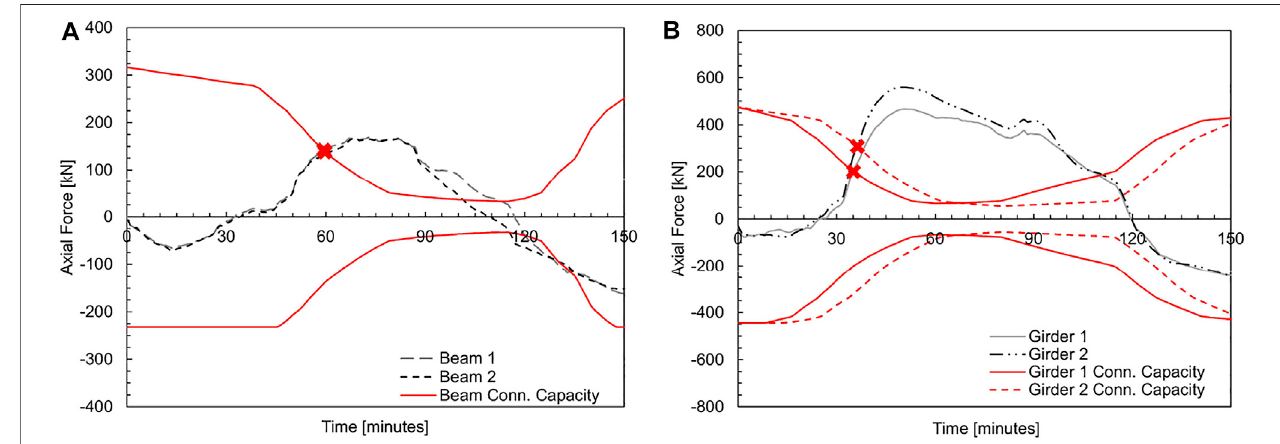
FIGURE 19 | Axial force histories and connection capacities for (A) beams and (B) girders connecting to column C-2 for Fire Scenario #3 (SFE